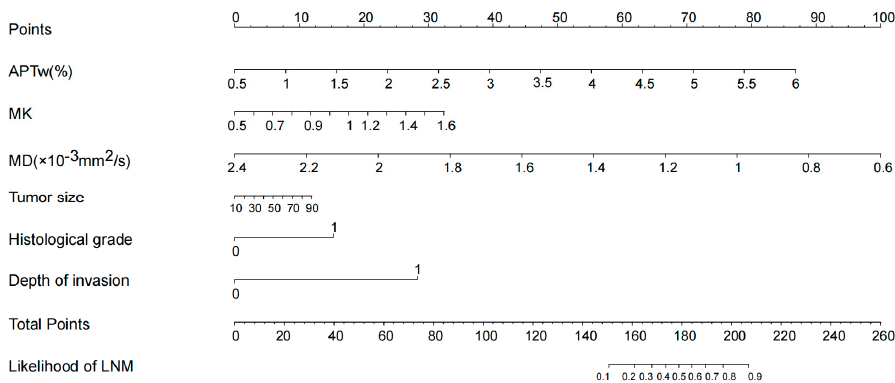
Figure 5. According to the logistic regression model, the nomogram was obtained. The probability of LNM was calculated by substituting various factors into the nomogram.